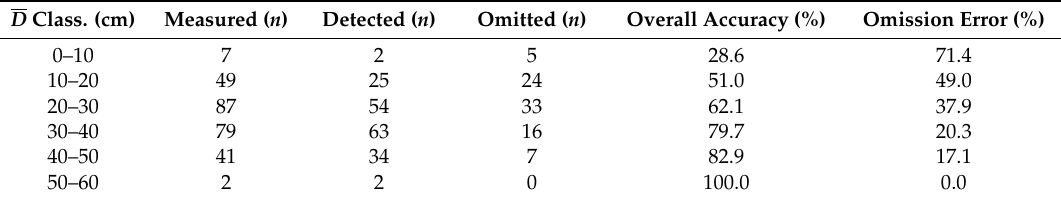
Table 2. Accuracy assessment for the tree-stump detection according to six different 10 cm wide D classes for stratum 1.